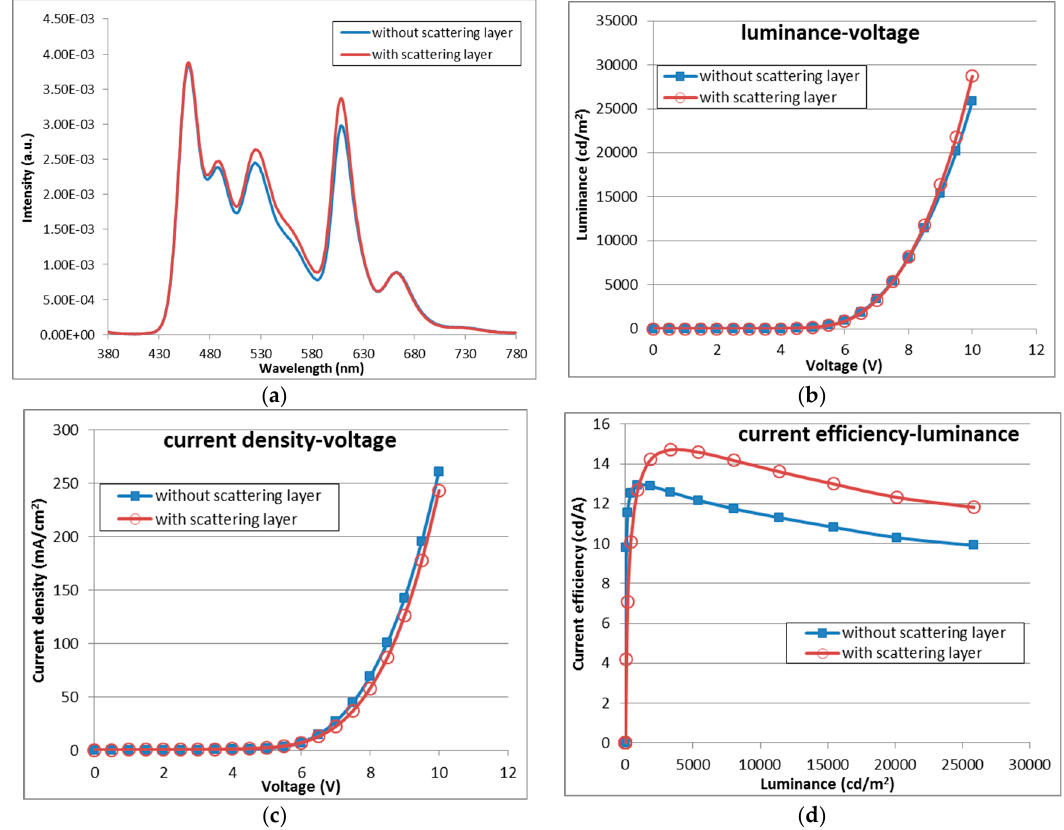
Figure 4. Characteristics of OLED devices with and without the YSZ scattering layer. The thickness of the YSZ scattering layer is 2.5 um: ( a ) Electroluminescence spectrum of the OLED devices. The spectrum data are normalized at 1mA/cm 2 ; ( b ) Characteristics of luminance for different voltages; ( c ) Characteristics of current density for different voltages; and ( d ) Characteristics of current efficiency for difference luminance.